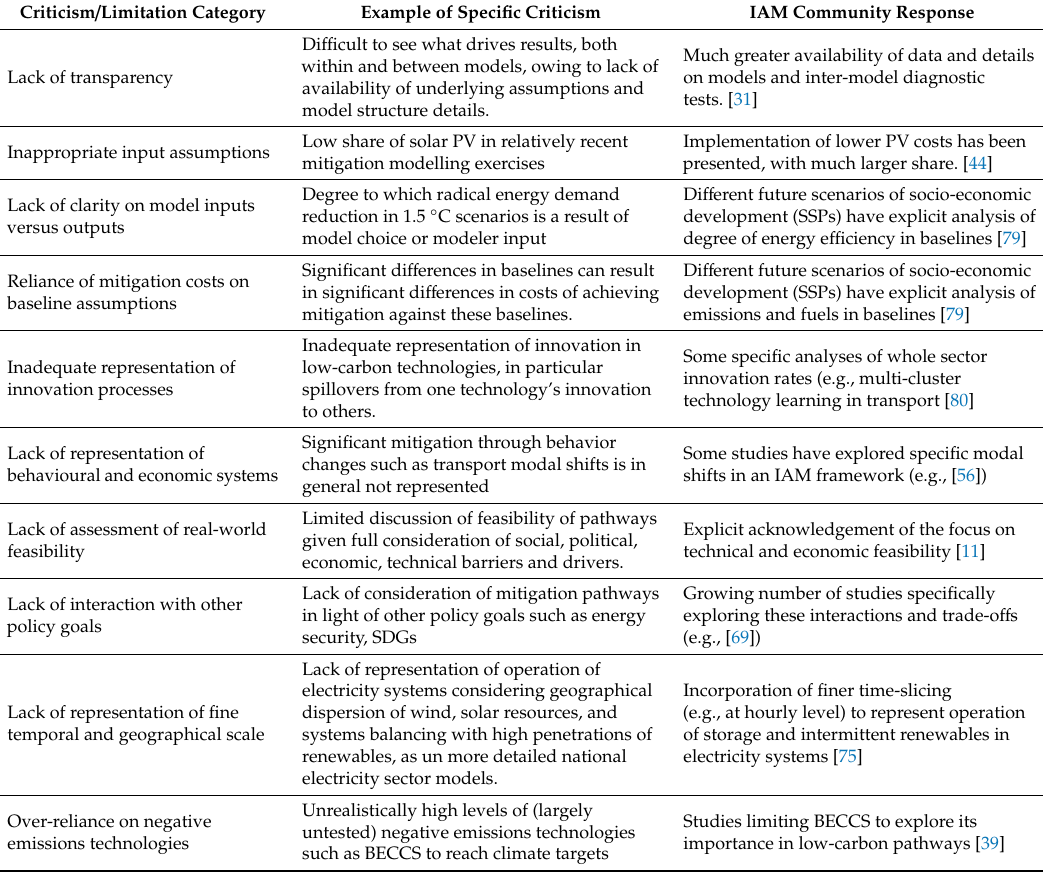
Table 1. Summary of criticisms of IAMs and responses to